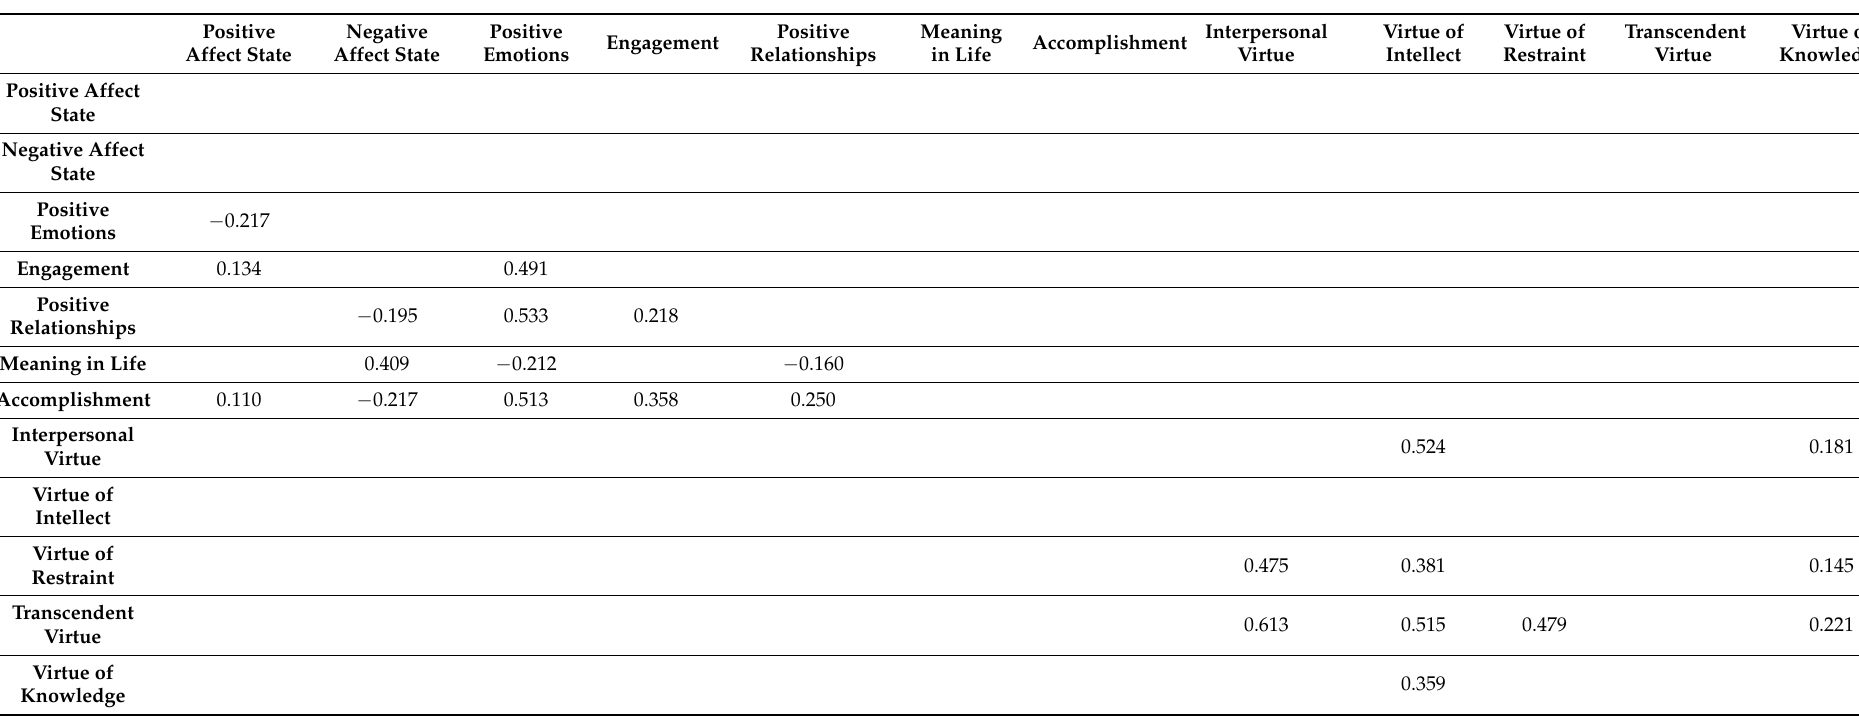
Table 7. Correlations between demographics, virtues, and subjective wellbeing